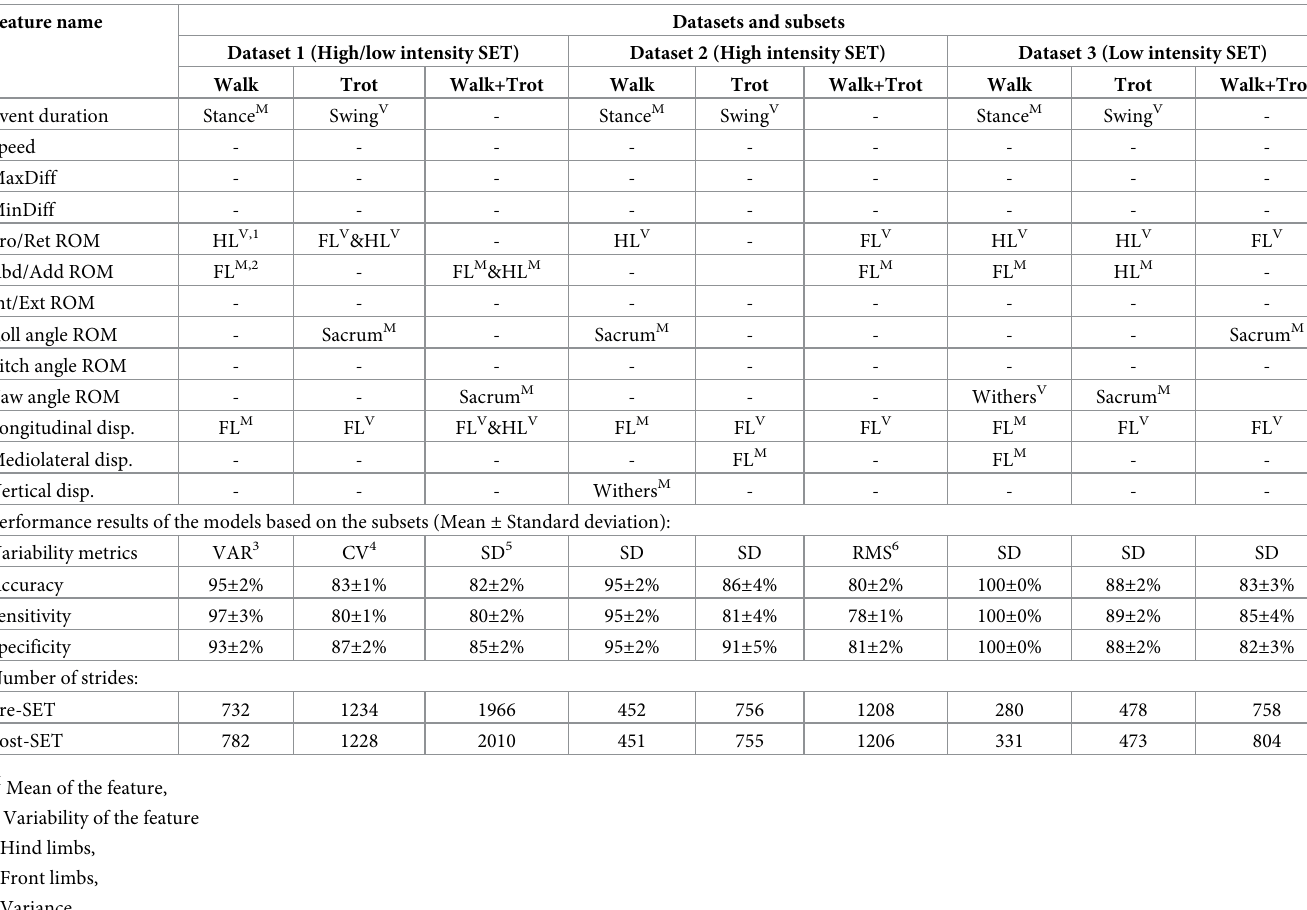
Table 3. Features (mean and variability) with highest weight value based on different subsets, the best performing variability, the average performance results of the SVM classification models from leave-one-subject-out cross validation (reported as mean ± standard deviation), and the number of strides per